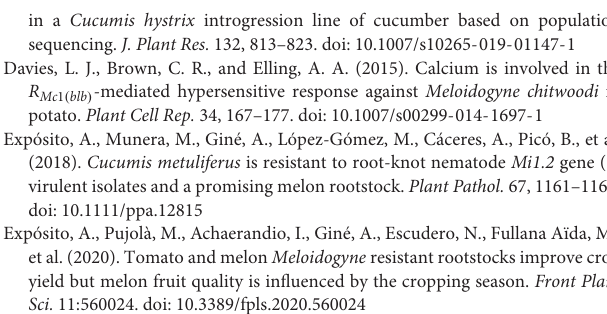
Supplementary Table 1 | Primers used in this study. Supplementary Table 2 | The statistics of RNA-seq sequencing data in this study. CM-ck, Q24-ck and CM-T, Q24-T represent the control and the treatment of CM and Q24. 1, 2, 3 represent three biological